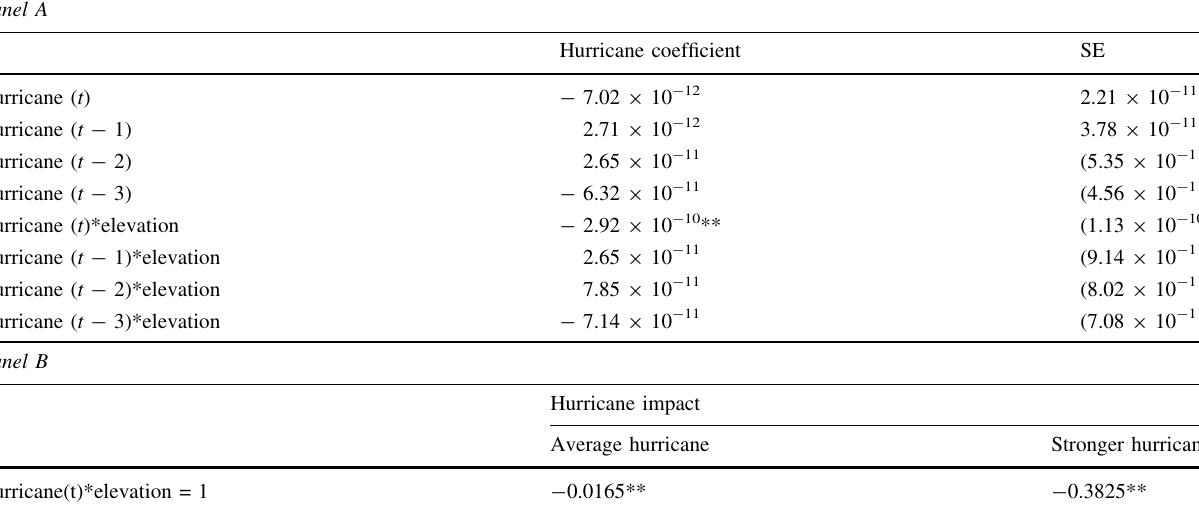
Table 8 Impact of hurricanes on production efficiency by elevation in the 17 Caribbean countries in the case study Panel